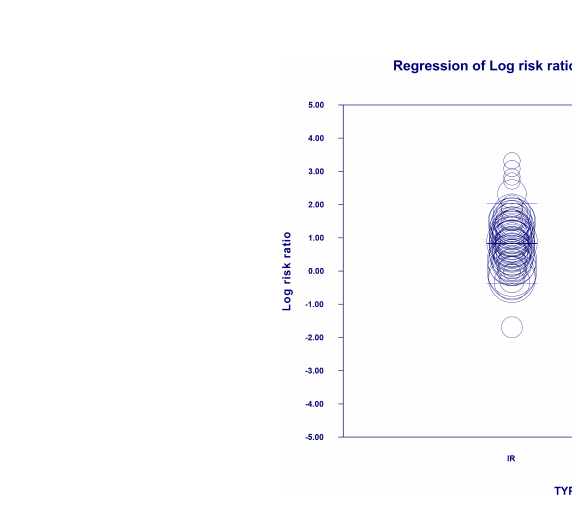
FIGURE 8 Regression for RR toward diarrhea by type of metformin. XR, extended release; IR, immediate